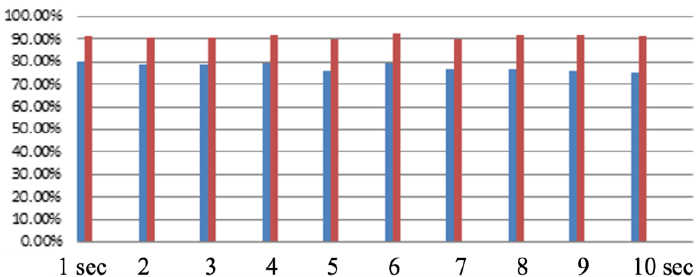
Figure 9. The accuracy values of input data average (blue bars for SVM and red bars for RF).